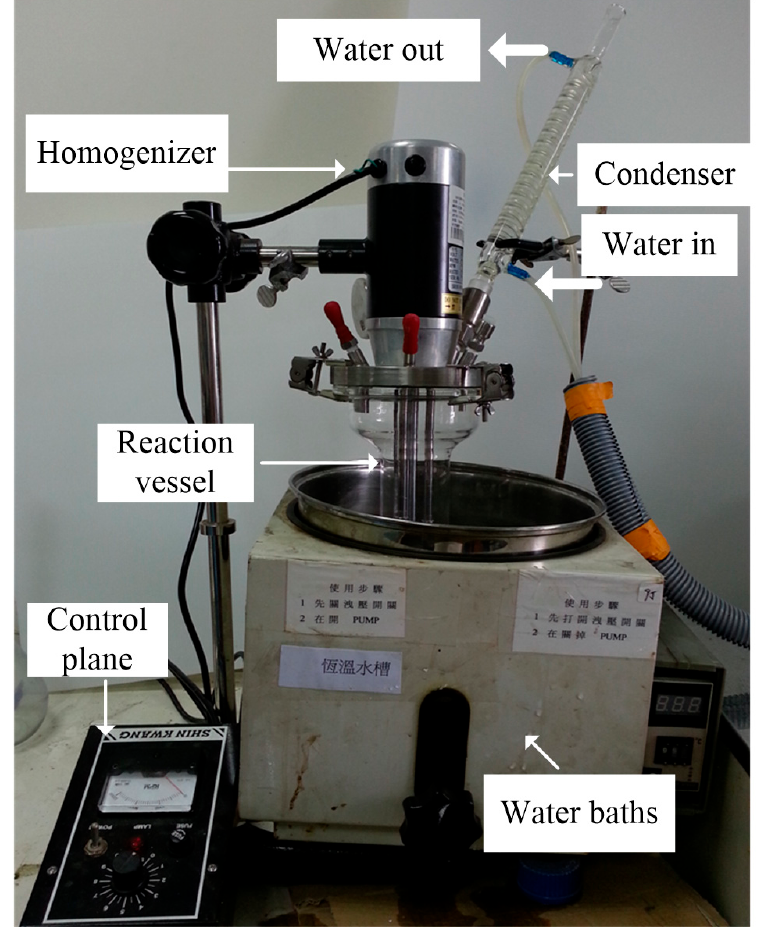
Figure 1. Experimental apparatus [33–35].